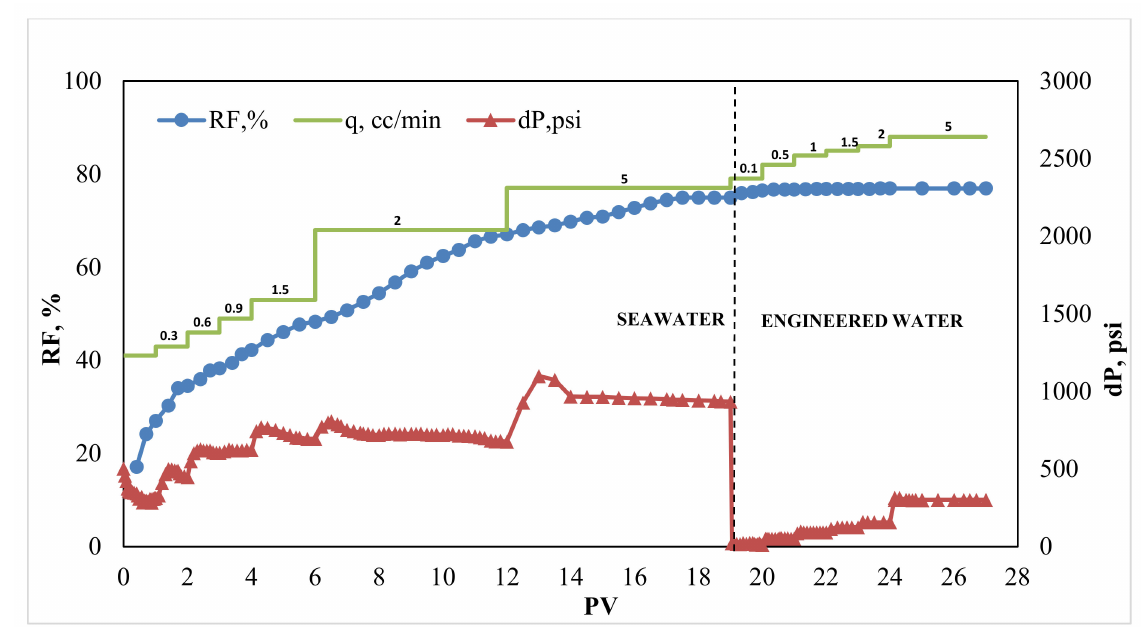
Figure 5. Engineered water (EW2) injection core flooding results (5 × Diluted CSW with 2Mg ∗ 2SO 4 ions).